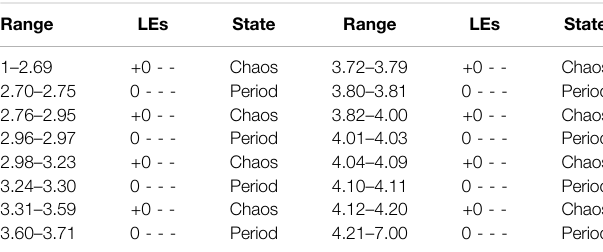
TABLE 1 | The state and LEs under the change of parameter a